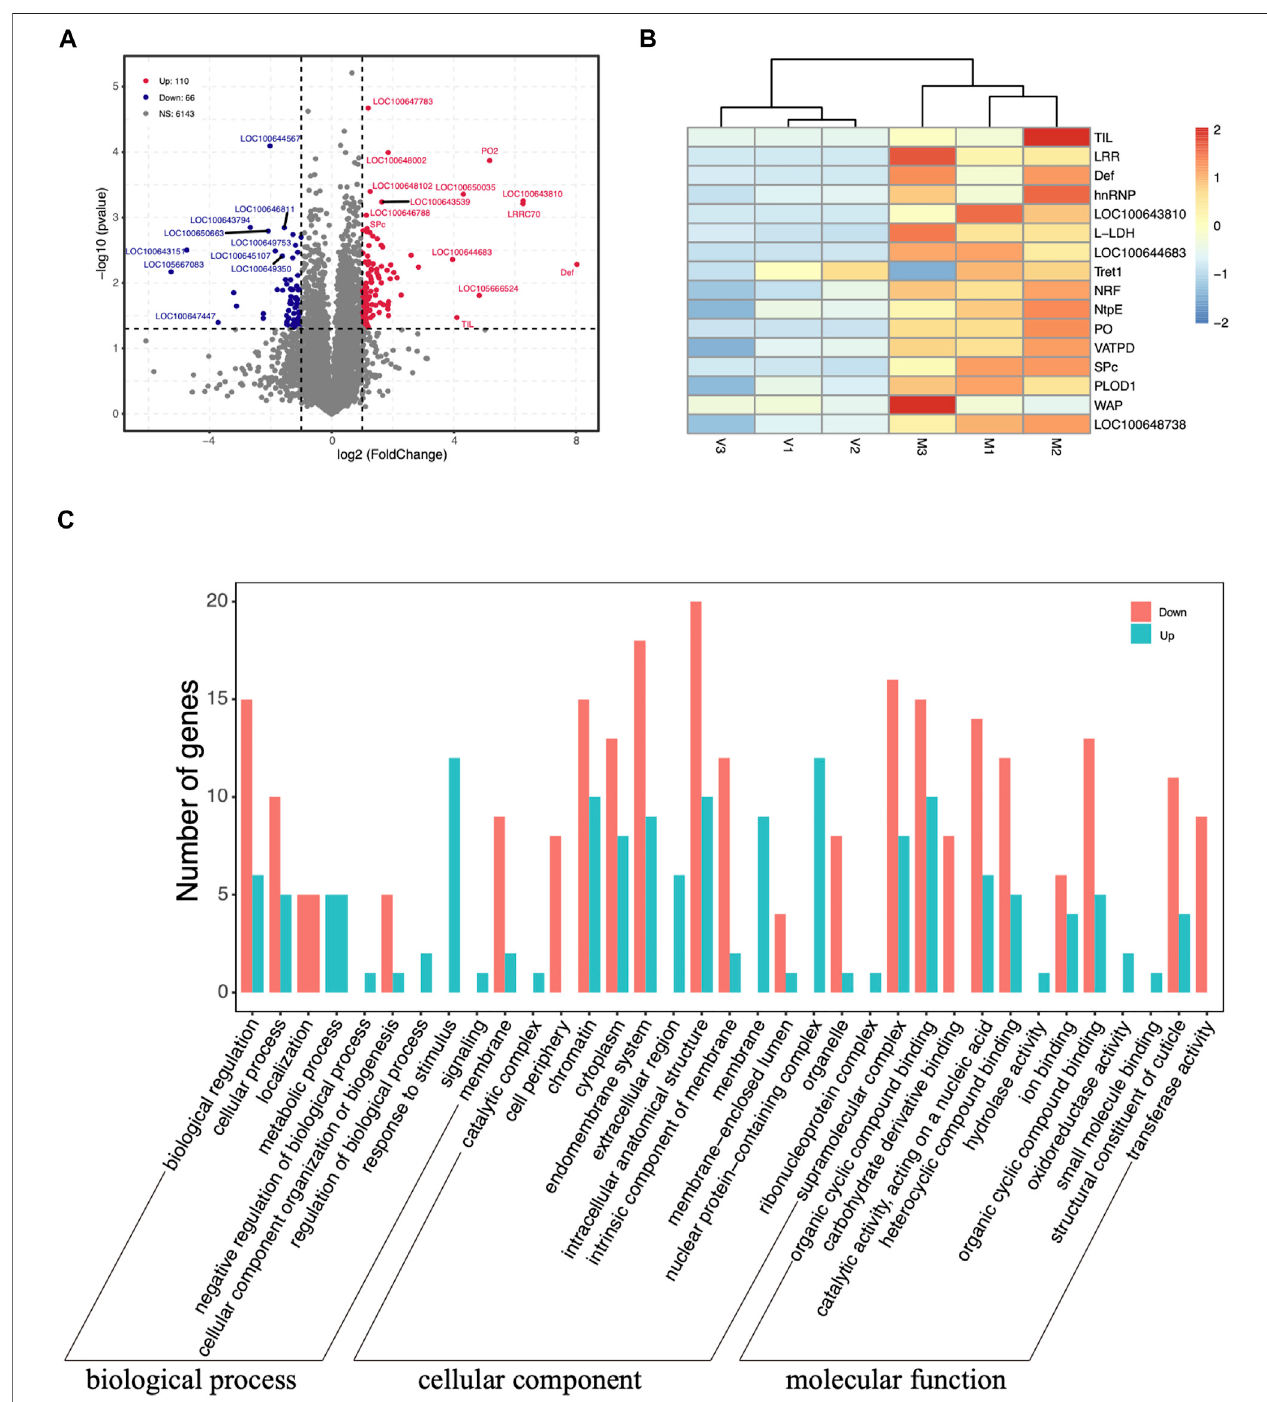
FIGURE 2 | (A) Volcano plots displaying the upregulated (red dots) and downregulated (blue dots) differentially expressed genes between the spermathecae of mated and virgin bumblebee queens. Each dot represents one gene. The gray dots represent genes that were not differentially expressed [ p > 0.05 and |log2 (fold- change)| ≤ 1]. (B) Expression pro fi le of transcripts that were differentially expressed according to RNA-seq between mated and virgin bumblebee females at 24 h post mating. The heatmap shows the transcriptome data of the selected genes, which are based on the log2 (FPKM) values of genes in virgin and mated females. The color scale represents the scale of the log2 (FPKM) values. The tissues used in the analysis ( n (cid:2) 3 biological replicates per tissue type) were spermathecae from mated queens( “ M ” ),andspermathecaefromvirginqueens( “ V ” ).Thecolorindexatthetopindicatesthegenesthatwereexpressed atrelativelylowlevels(blue)orathighlevels (red) in each row. Heat maps were generated using the heatmap R package. (C) Distribution of up- and downregulated DEGs among the Gene Ontology (GO) terms in the biological process, cellular component, and molecular function categories.